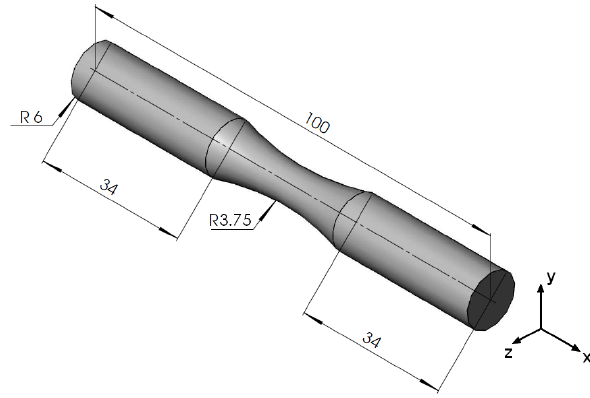
Figure 1. Specimen geometry and respective dimensions in (mm) [38].